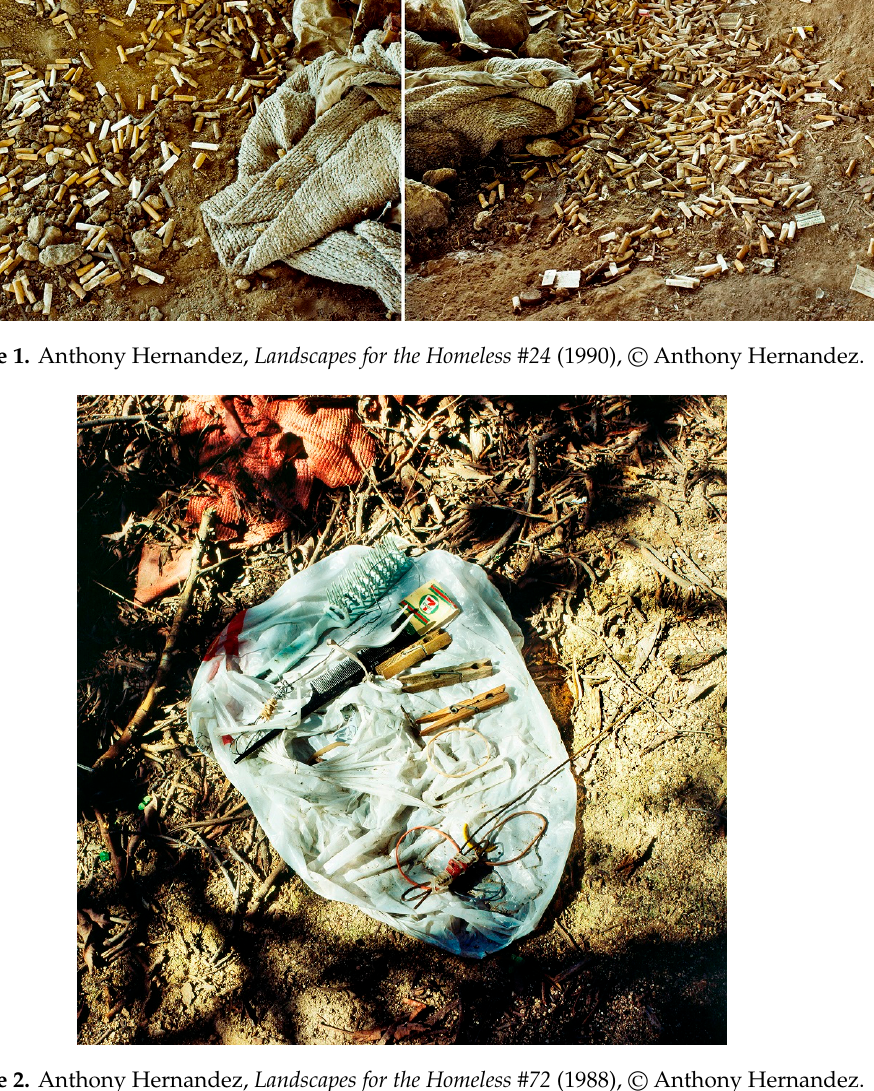
Figure 2. Anthony Hernandez, Landscapes for the Homeless #72 (1988), © Anthony Hernandez.